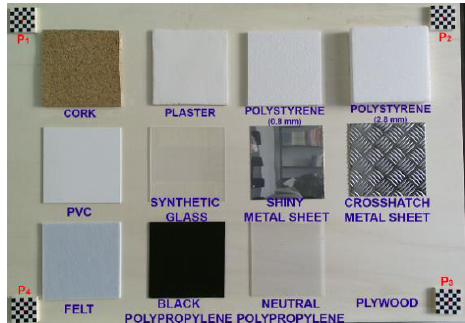
Figure 4. The panel with the samples of the chosen materials. The target points used to georeference the different point clouds are indicated by red dots